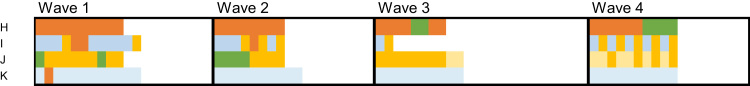
Examples of partial modal shift patterns. Each horizontal line is an individual. The waves are separated by vertical black lines. Each trip is one square, individually colour-coded and the length of the line corresponds with the number of commute trips made over one week. Each colour represents one modal combination. Orange = car only; green = bicycle only; blue = walk only; yellow = train only; and brown = bus only. The white colour indicates no trip was made. Full legend: see Appendix D. (For interpretation of the references to color in this figure legend, the reader is referred to the web version of this article.)